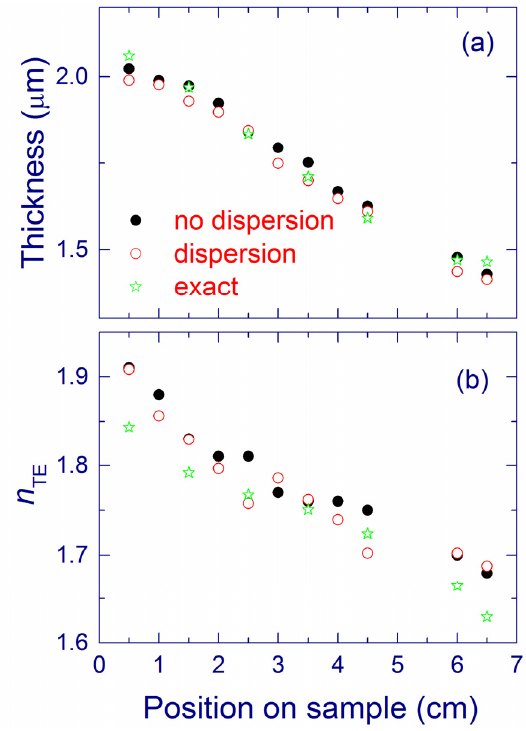
Figure 21. Optical parameters of a SiO x optical wedge (1.5 < x < 1.8) obtained with different models: simple model (solid circles), taking dispersion into account (open circles), and using the exact equations [153] (stars). Reproduced with permission from [115]. Copyright 2008, AIP Publishing